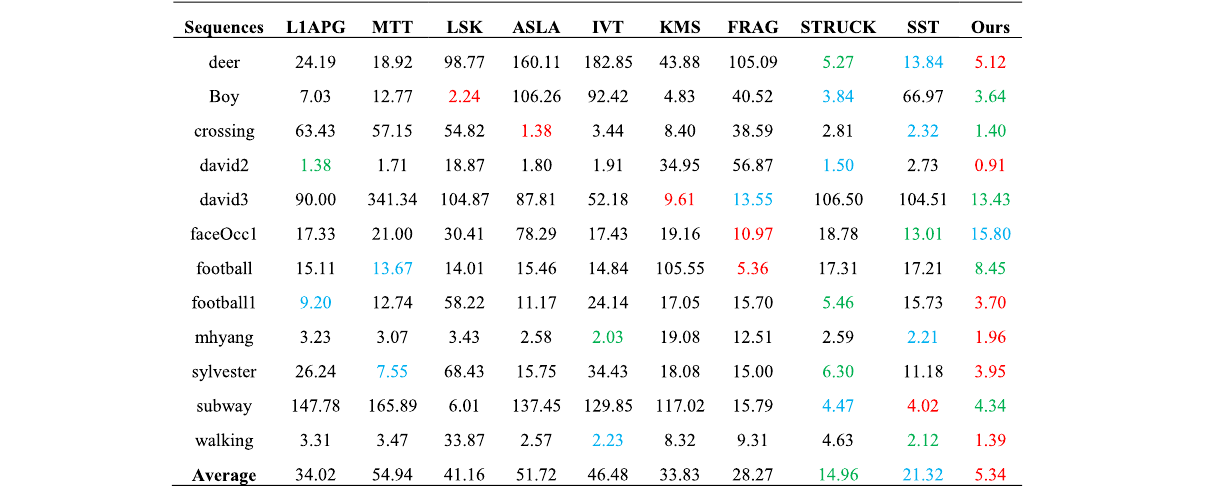
Table 2 Average center error for each sequence with 9 state-of-the-art